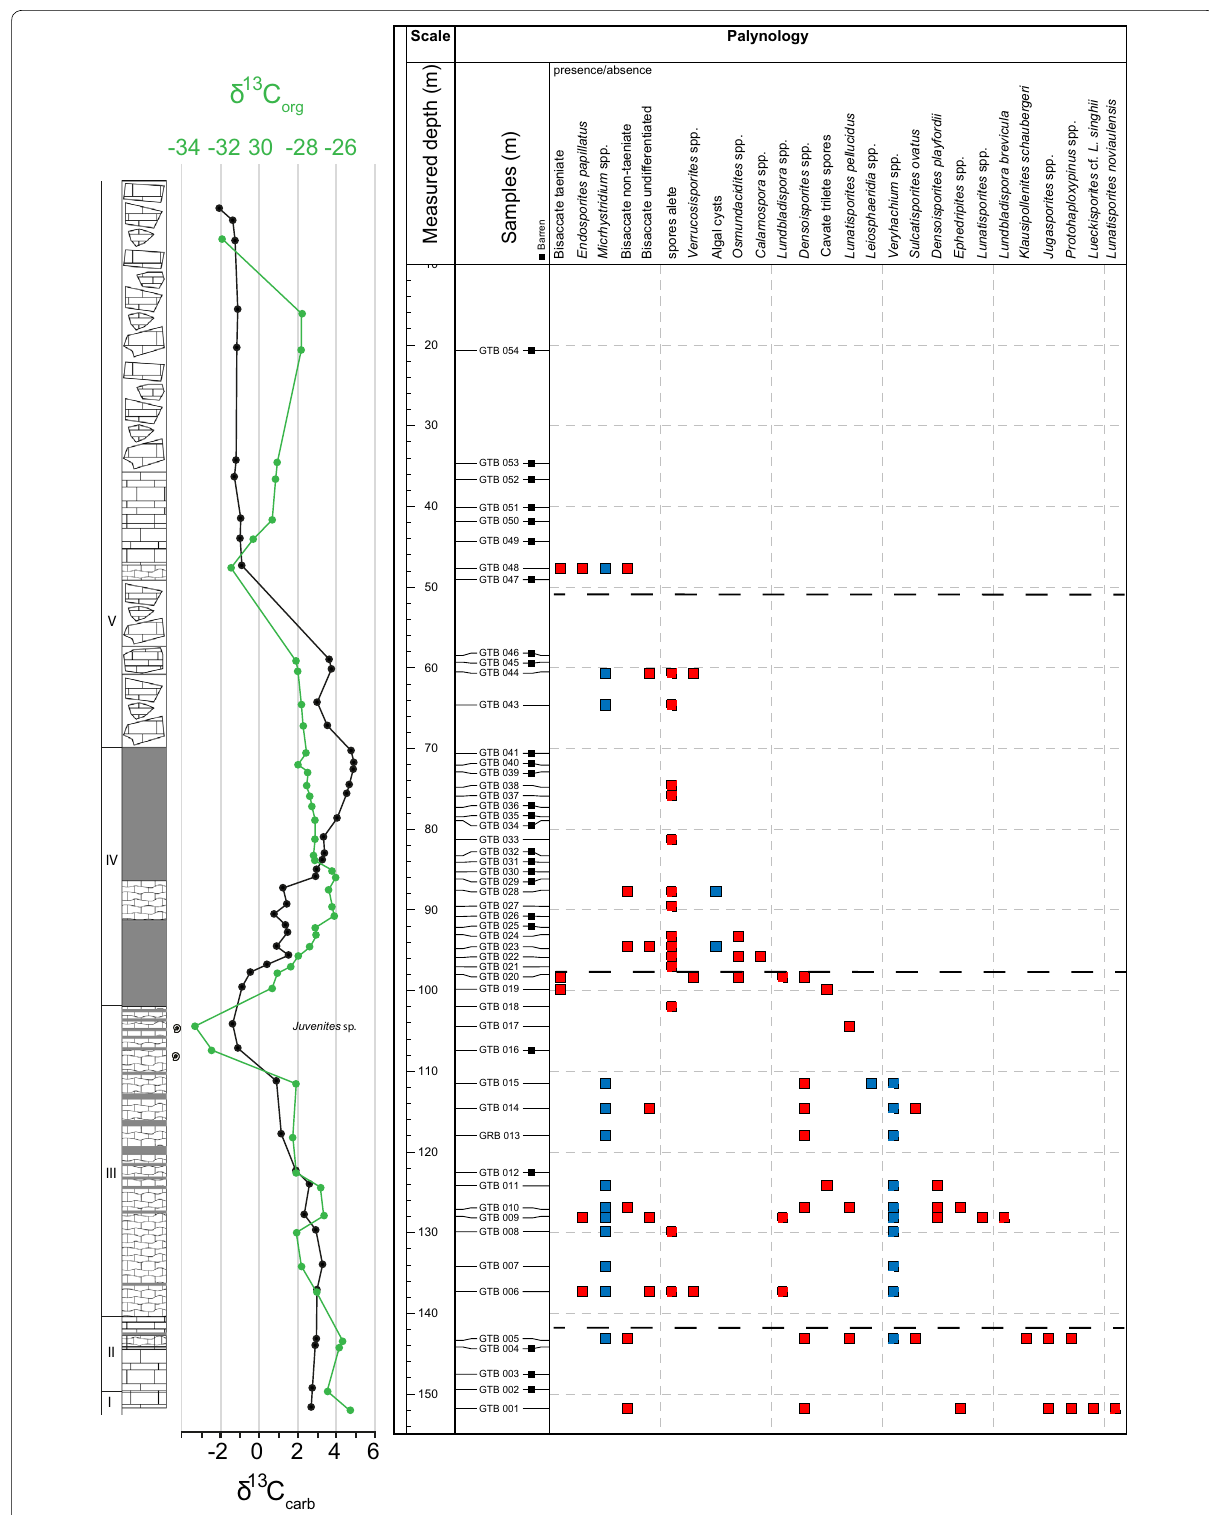
Fig. 5 Presence/absence data of palynomorphs ordered according to their stratigraphic last occurrence. Each square represents only one or maximum two occurrences of the respective